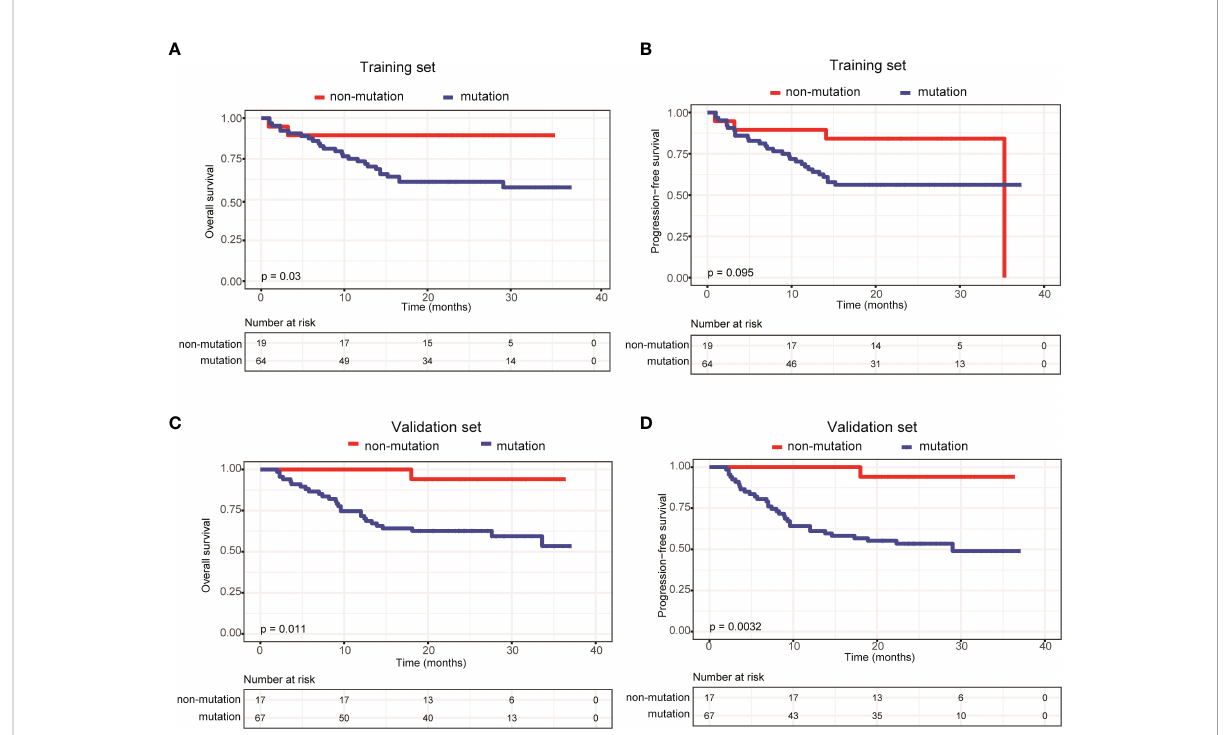
FIGURE 3 Patients carrying ctDNA mutations trended to have poor prognosis. Kaplan-Meier curves were applied to compare the (A) OS and (B) PFS between patients with and without ctDNA mutations in the training set. Kaplan-Meier curves were applied to compare the (C) OS and (D) PFS between patients with and without ctDNA mutations in the validation